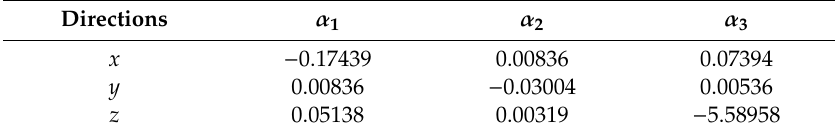
Table 6. Coefficients for the superposition method in AB/F-DW corrugated paperboard. Directions